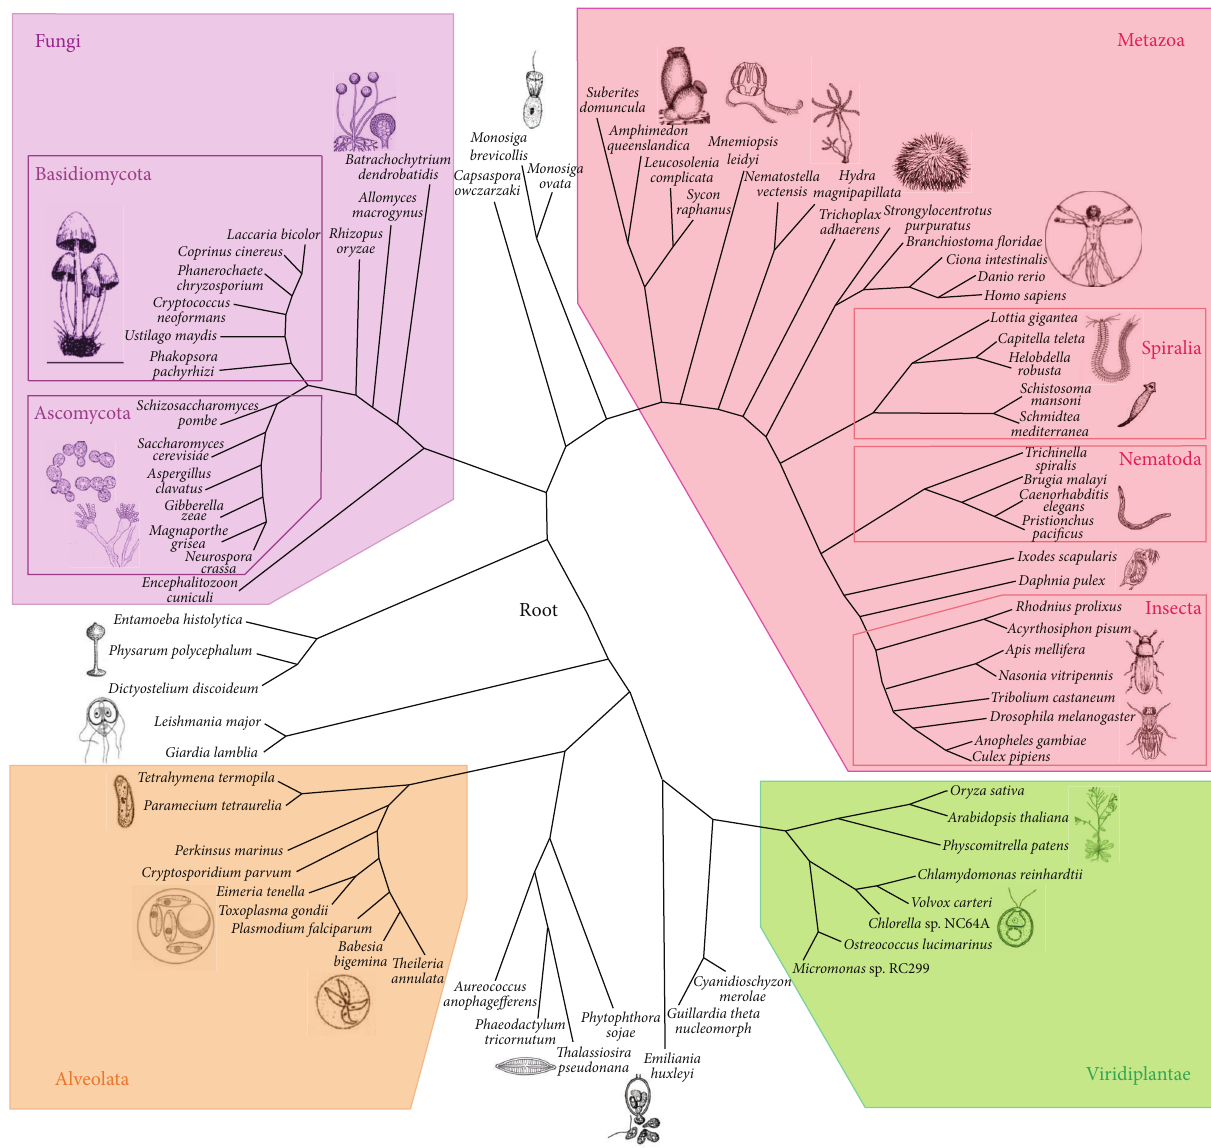
Figure 1: The phylogenetic tree for the initial species set according to